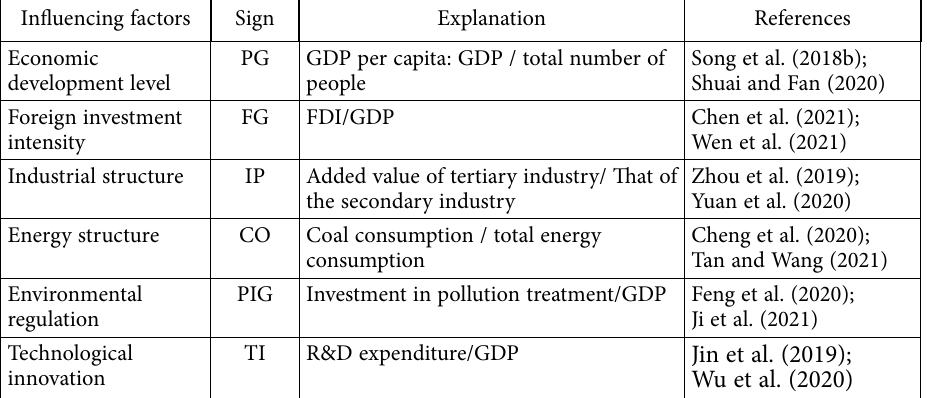
Table 6. Influencing factors and explanations Influencing factors